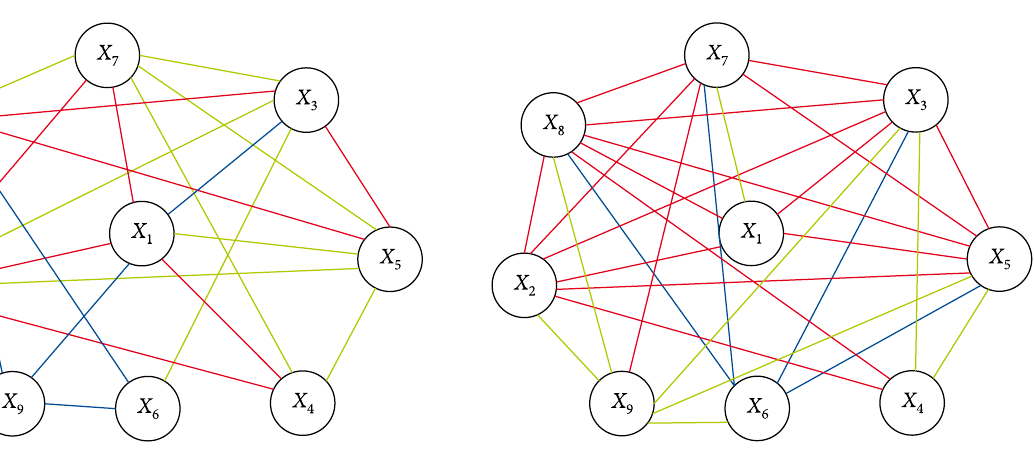
2 pav. Niveliacijos linijos Vilnius – Jonava koreliacijos grafas Fig. 2. Graph correlation of levelling line Vilnius –